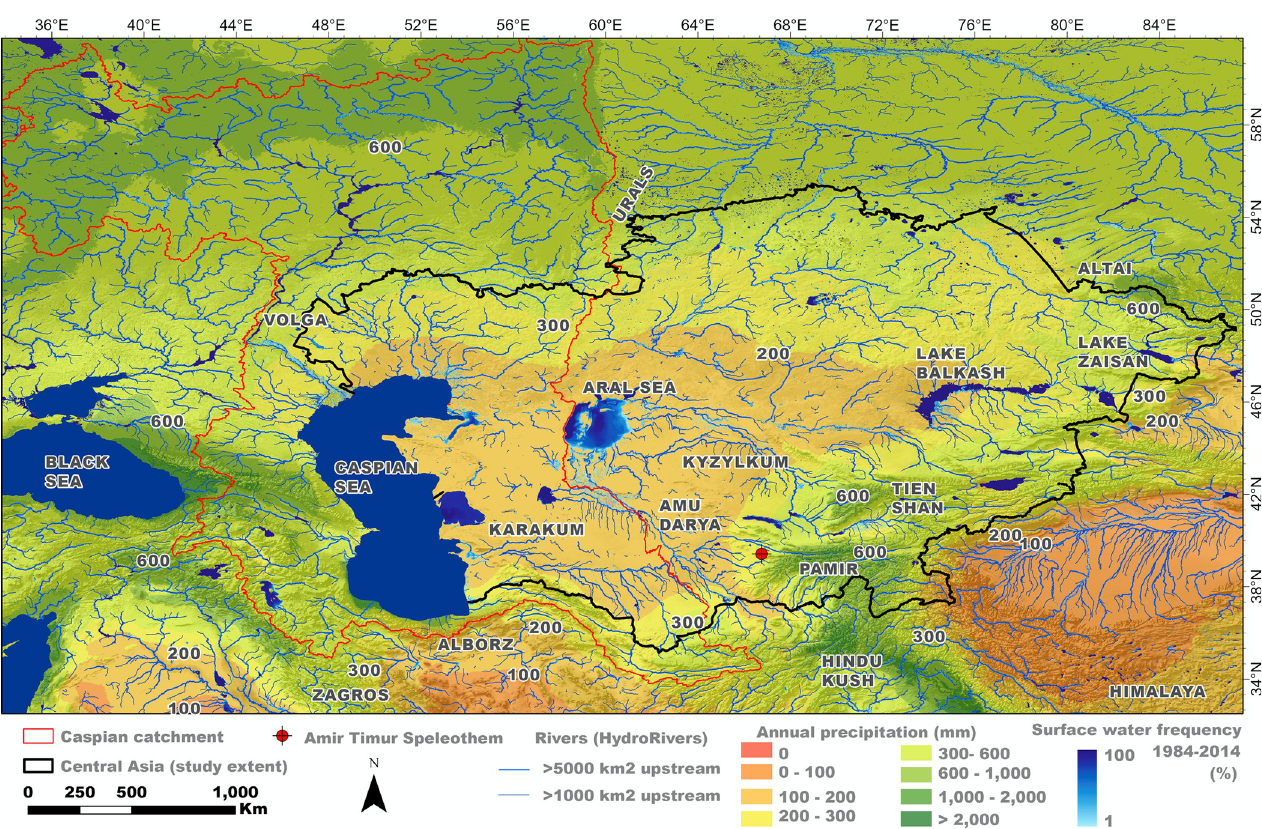
Fig 1. The study region. A map of Central Asia derived by the authors using data for annual precipitation (Worldclim [14]), surface water [15], and rivers (Hydrosheds [16]). The study region (encircled with black line) is shown with the region of Caspian catchment (enclosed with red line). Key mountain ranges, deserts, and bodies of water are labeled. The location of Amir Timur Cave that hosted stalagmite S-12-4 analyzed in this study is shown as red circle.